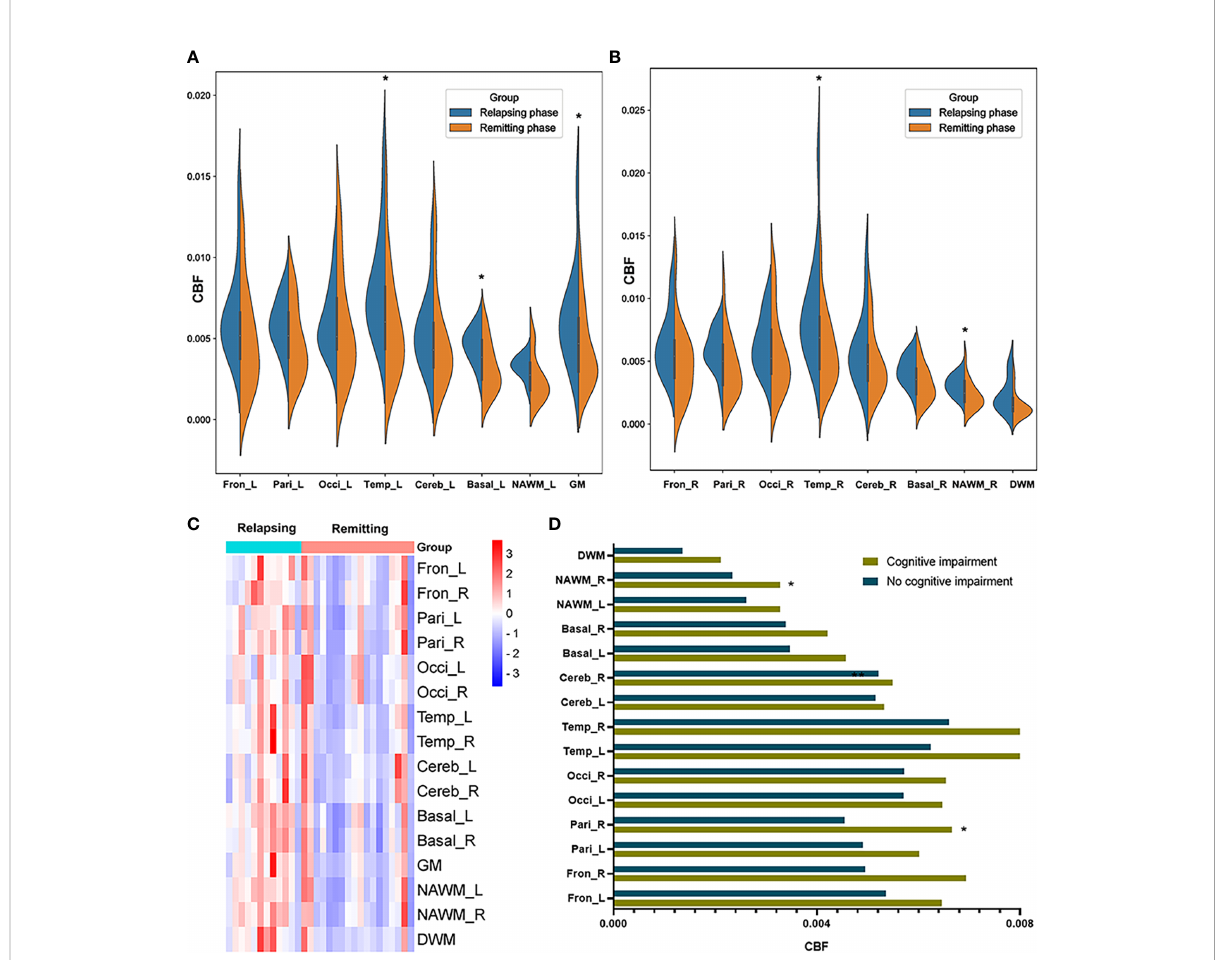
FIGURE 3 CBF differences between MS patients in the relapsing phase and remitting phase, and between MS patients with and without cognitive impairment. (A, B) Comparison of CBF between MS patients in the relapsing phase and remitting phase; (C) CBF cluster heatmap of different regions in different phases; and (D) MS patients with cognitive impairment showed increased CBF in the right parietal lobe and right NAWM compared to those without. * p < 0.05 vs. patients in remitting phase/without cognitive